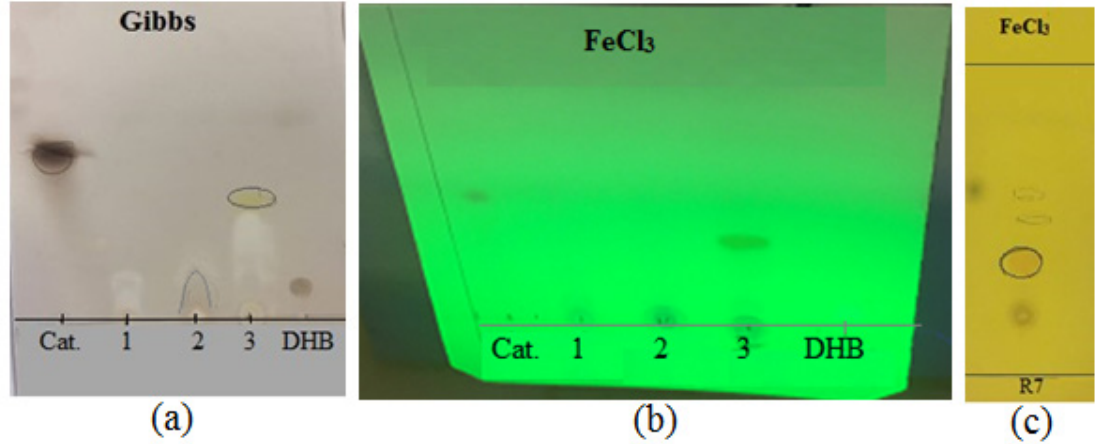
Figure 3. Detection of siderophore types by TLC with FeCl 3 and Gibbs reagents. In ( a , b ), the left spotted sample (Cat.) was catechol and the right spotted sample (DHB) was 3,4 dihydroxybenzoic acid; main samples were spotted in the middle; 1, 2 and 3 spots indicate control, F8 and R7 actinomycete isolates, respectively. Plate ( a ) shows the results in Gibbs reagent in which the brown color indicates the presence of phenolic siderophores. Plates ( b , c ) show the results in FeCl 3 reagent, indicating the presence of hyderoxamate siderophore in red color and phenolic compounds such as catechol in blue or greenish colors.